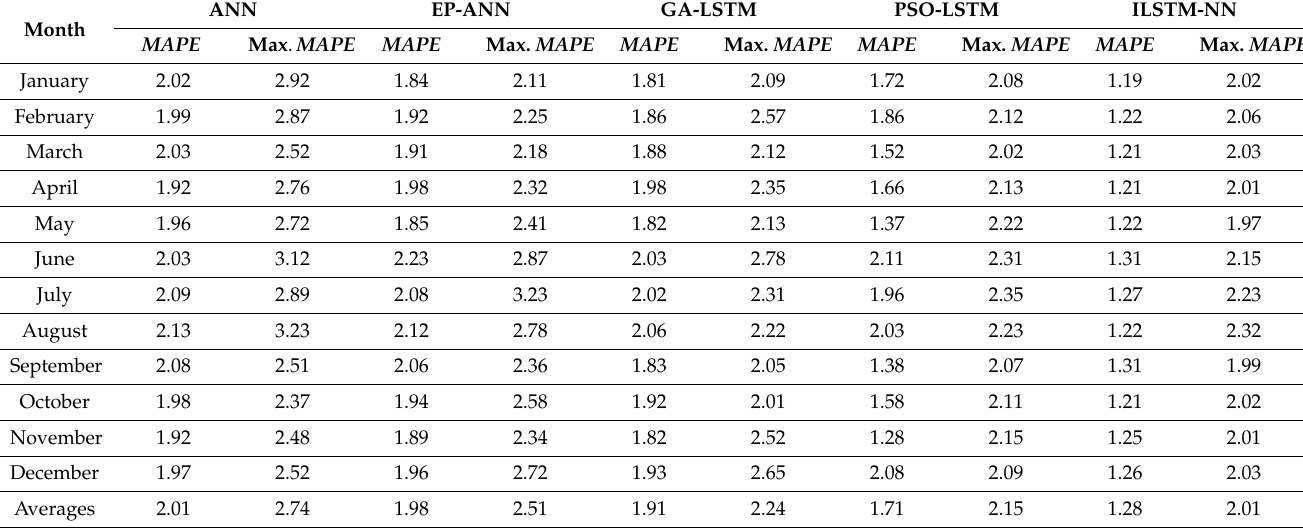
Figure 11. The MAPE and Max. MAPE of the load forecasting for a particular working day (Thursday 15 October 2020) compared with the other four different methods.